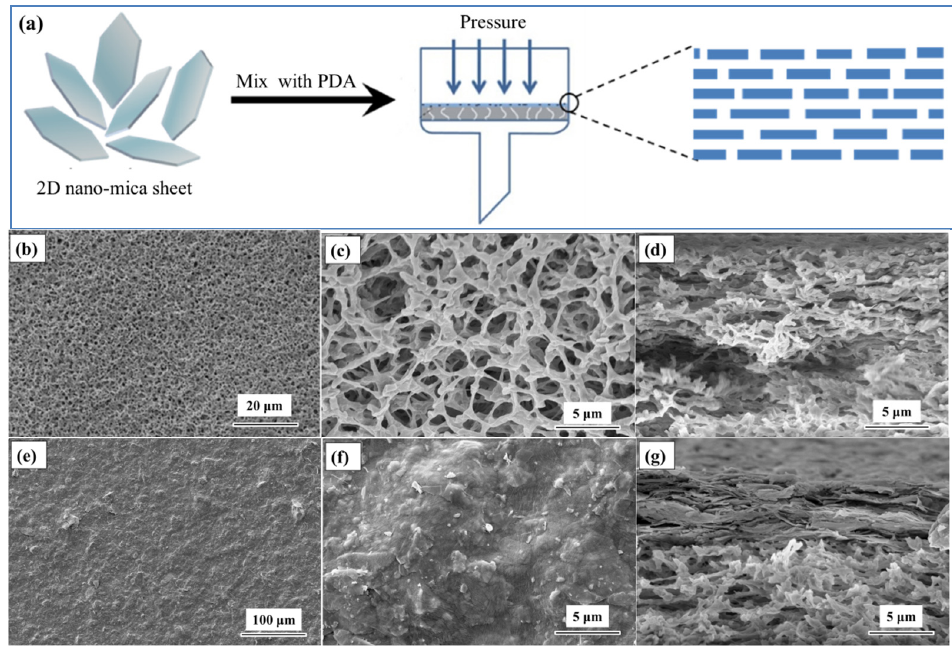
Figure 3. ( a ) Schematic diagram of the assembly process of NCM; ( b ) and ( c ) SEM images of PVDF membrane surface, ( d ) SEM images of PVDF membrane cross sectional, ( e , f ) SEM images of NCM membrane surface, ( d ) SEM images of PVDF membrane cross sectional, ( e ) and ( f ) SEM images of surface, ( g ) SEM images of NCM cross NCM surface, ( g ) SEM images of NCM cross sectional.